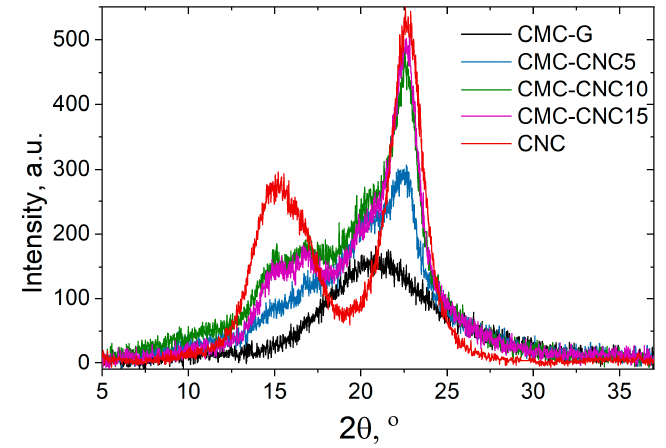
Figure 7. XRD pattern of the components and the nanocomposites.